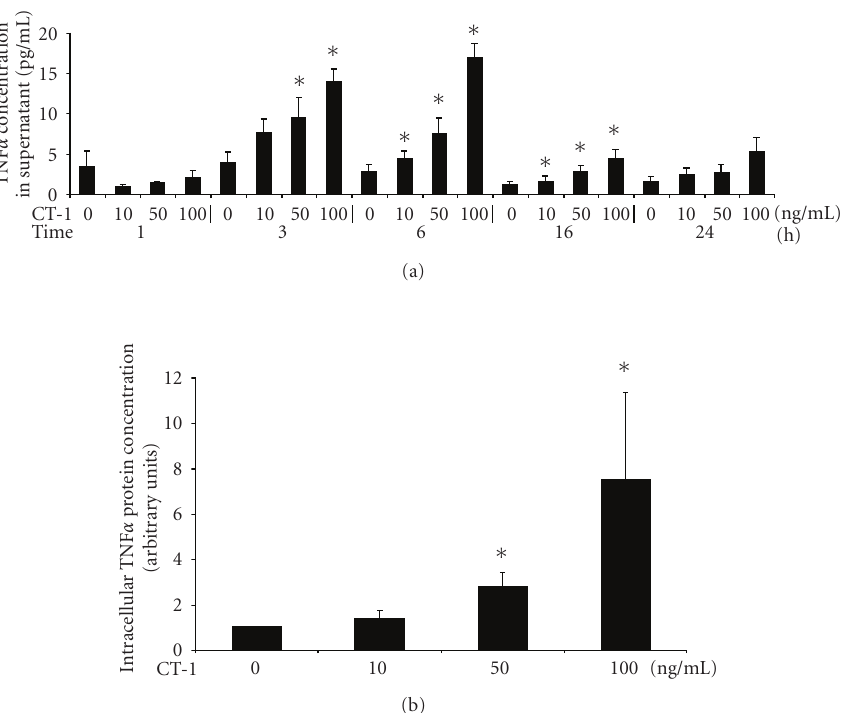
Figure 1: (a) Concentration- and time-dependent expression of TNF α protein in the supernatant after incubation with CT-1. Human PBMCs were incubated with various concentrations of CT-1 and for di ff erent periodes. After the indicated time TNF α protein concentration was determined by a commercial available ELISA. n = 5, data are expressed as mean ± SEM. ∗ P < . 05 compared to unstimulated cells. (b) Analysis of intracellular TNF α production using immunofluorescent flow cytometry. Human blood was incubated with di ff erent concentrations of CT-1 for 6hours in the presence of brefeldin A. Afterwards erythrocytes were lysed and cells were stained with a monoclonal antibody against CD14 FITC-conjugated and against TNF α PE-conjugated. Monocytes were gated and results are expressed normalized to unstimlulated monocytes. n = 11, data are expressed as mean ± SEM. ∗ P < . 05 compared to unstimulated